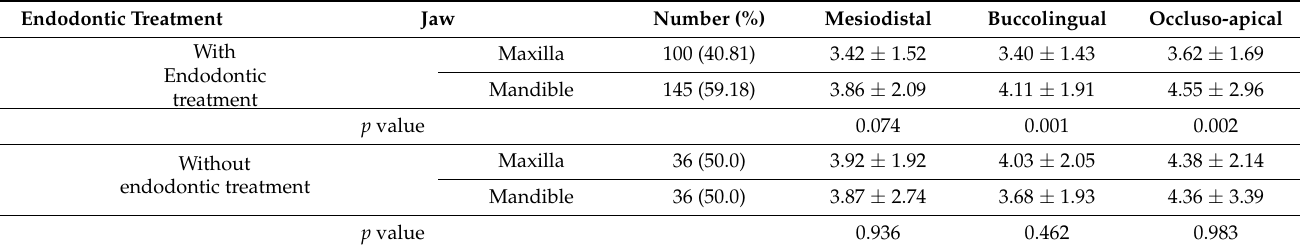
Table 4. Mean dimensions of endodontic lesions in treated and non-treated teeth based on the type of